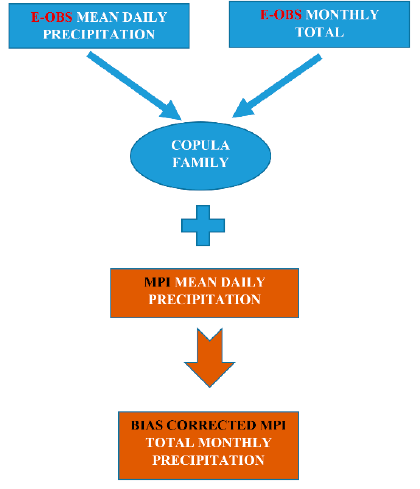
Figure 2. The followed method. Table 1. Denotation and properties of Elliptical and Archimedean copula families.